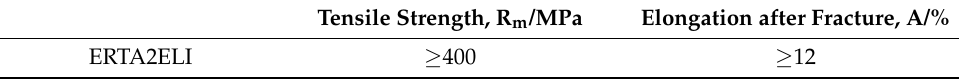
Table 2. The situation of the welding wire.